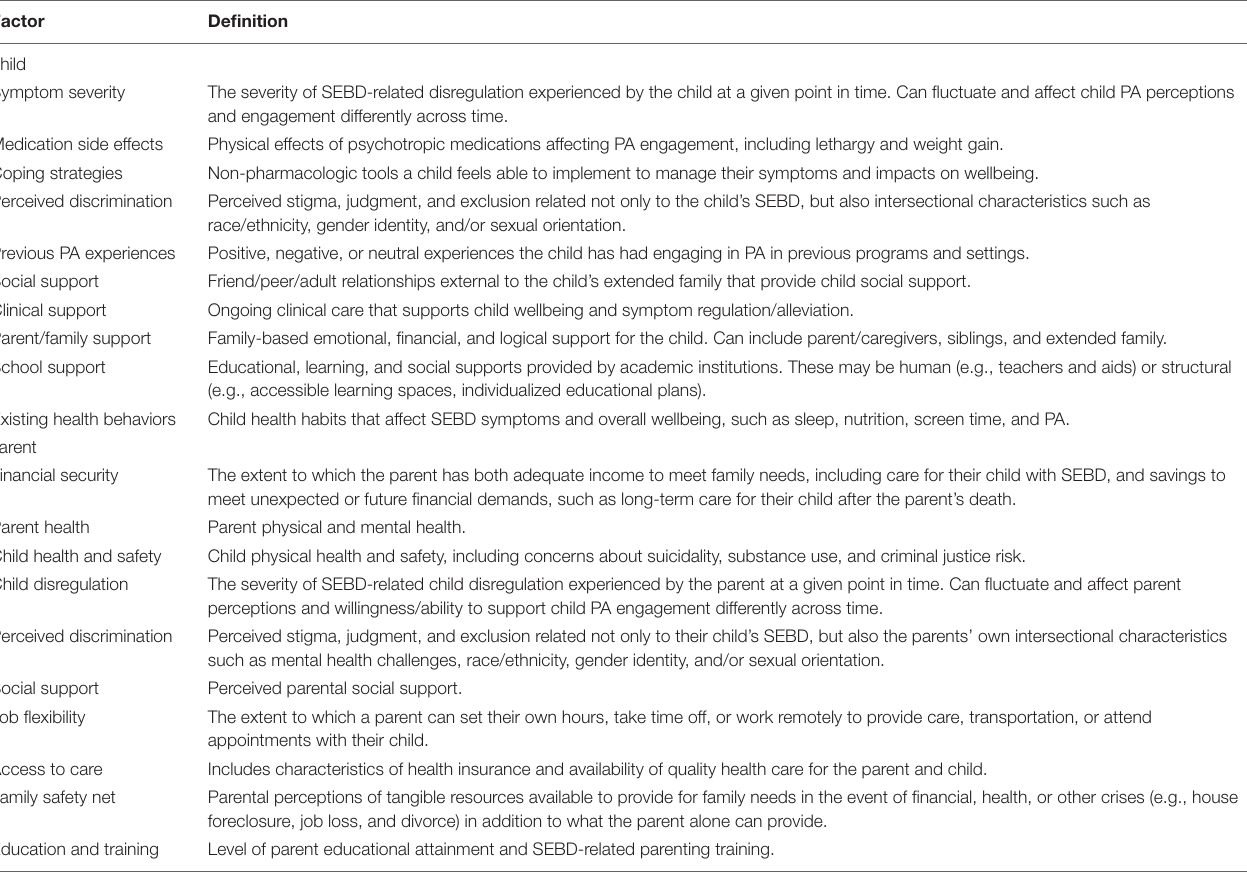
TABLE 1 | Definitions of factors affecting parent and child reserve